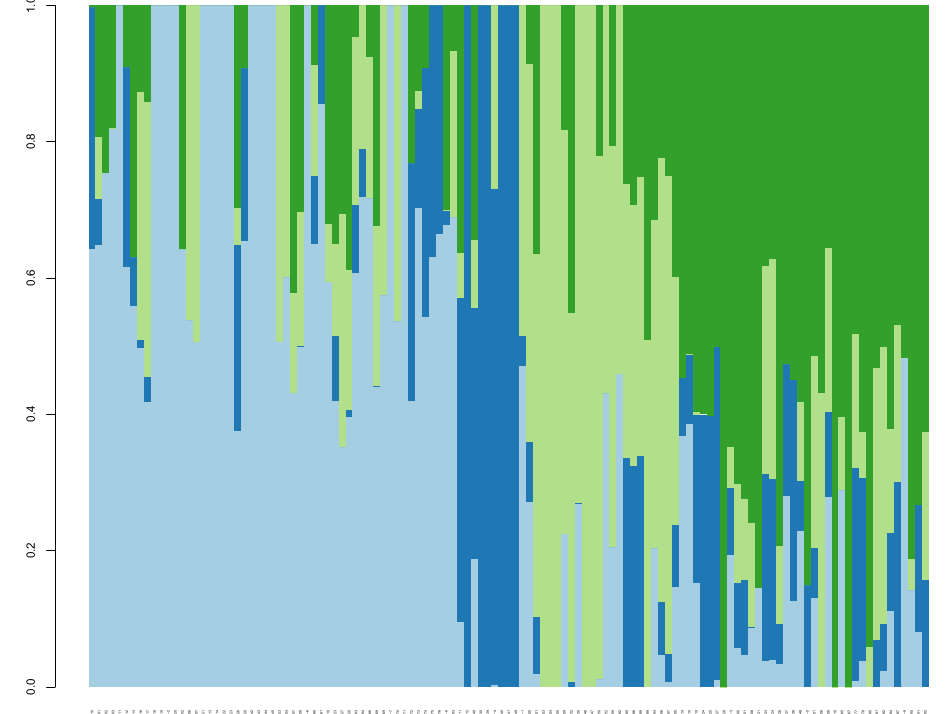
Figure 2. Population structure of 121 Non-heading Chinese cabbage.